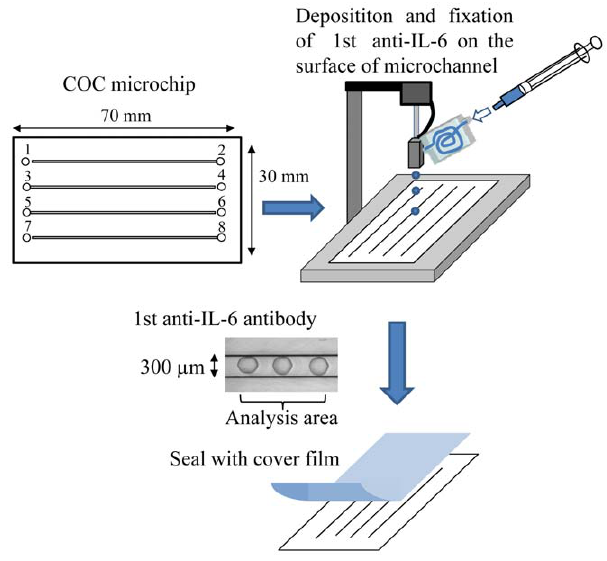
Figure 1. Schematic process for the detection of IL-6 and/or TNF- a on a microchip with deposition and fixation of 1st antibody by piezoelectric ink printing. After fixation of antibody on the surface of the microchannel and sealing with a cover film, blocking solution was infused into each microchannel from the reservoir (wells 1, 3, 5, and 7) by use of a pipetman.